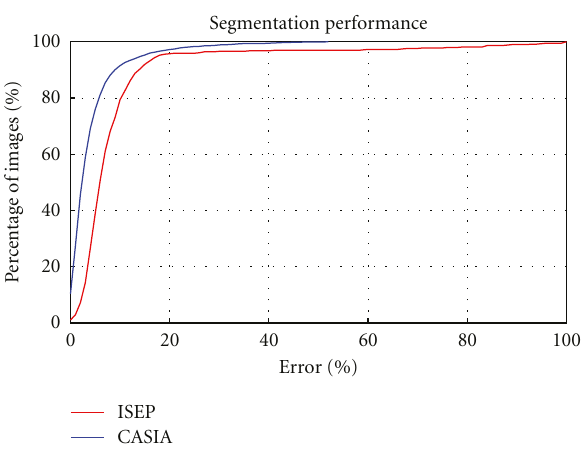
Figure 6: Global segmentation performance for the considered